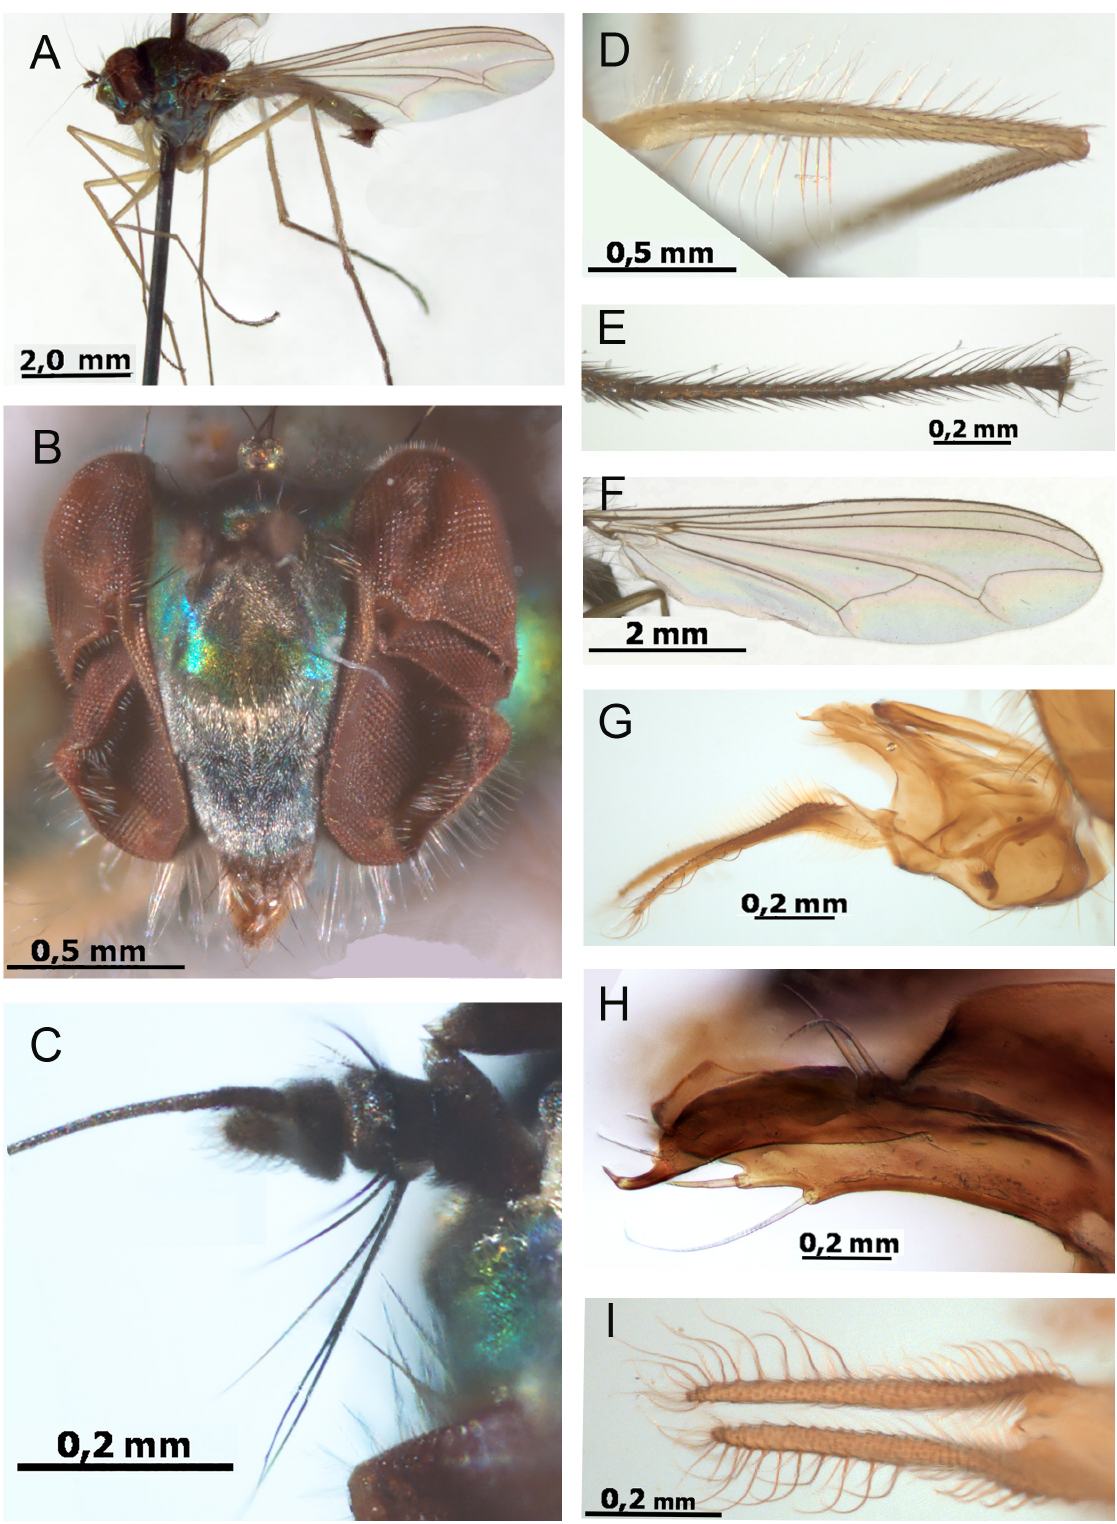
Fig. 5. Amblypsilopus mufindiensis sp. nov., holotype, ♂ (ZMUC). A . Habitus. B . Head. C . Antenna. D . Fore femur. E . Mid tarsus. F . Wing. G . Hypopygium after maceration, left lateral view. H . Surstylus, lateral view. I . Cerci, dorsal